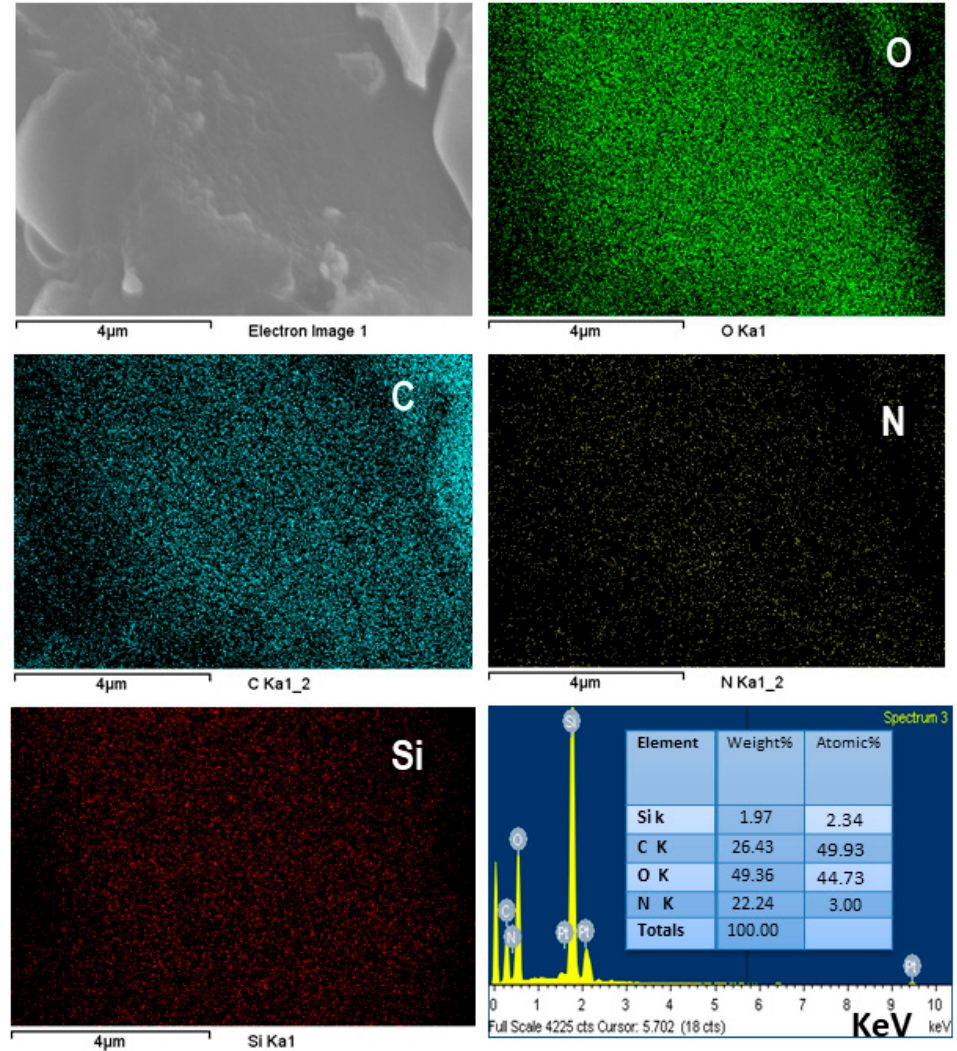
Figure 6. FE-SEM elemental mapping of Si ( red ), N ( yellow ), O ( blue ), and C ( ice blue ), and their electron image generated mapping image for CAPUOA/FS2. Last-right corner figure represents the EDX spectra of CAPUOA/FS2. Elemental wt.% is presented in the inset table.